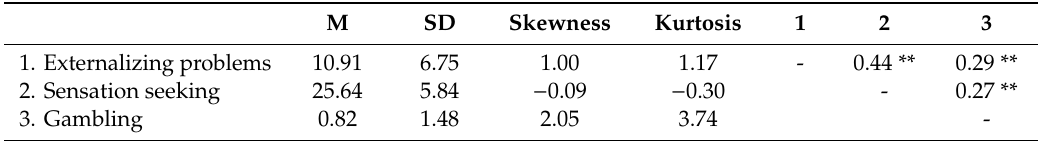
Table 1. Descriptive statistics and pairwise correlation coe ffi cients for all variables.